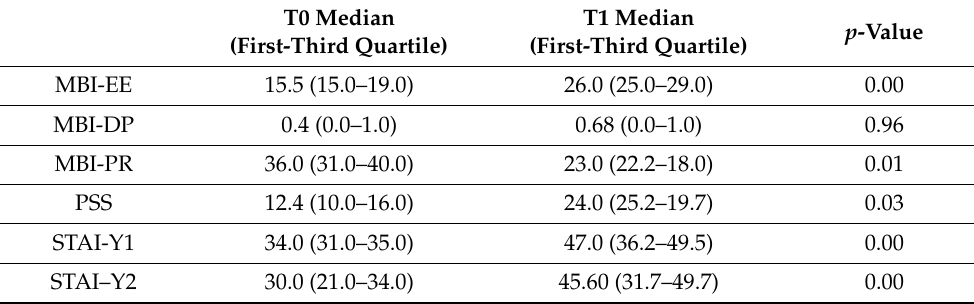
Table 3. Wilcoxon signed-rank test of neuropsychological